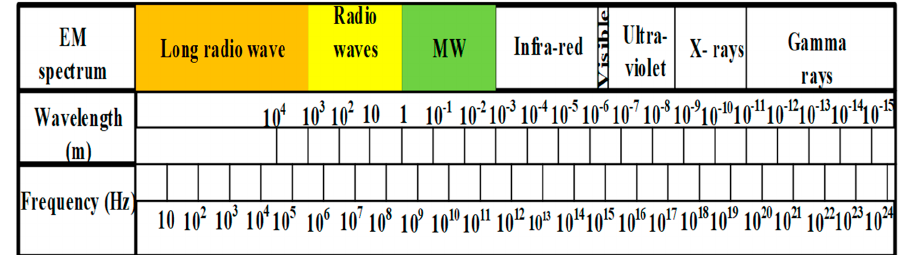
Figure 5. Electromagnetic spectrum.